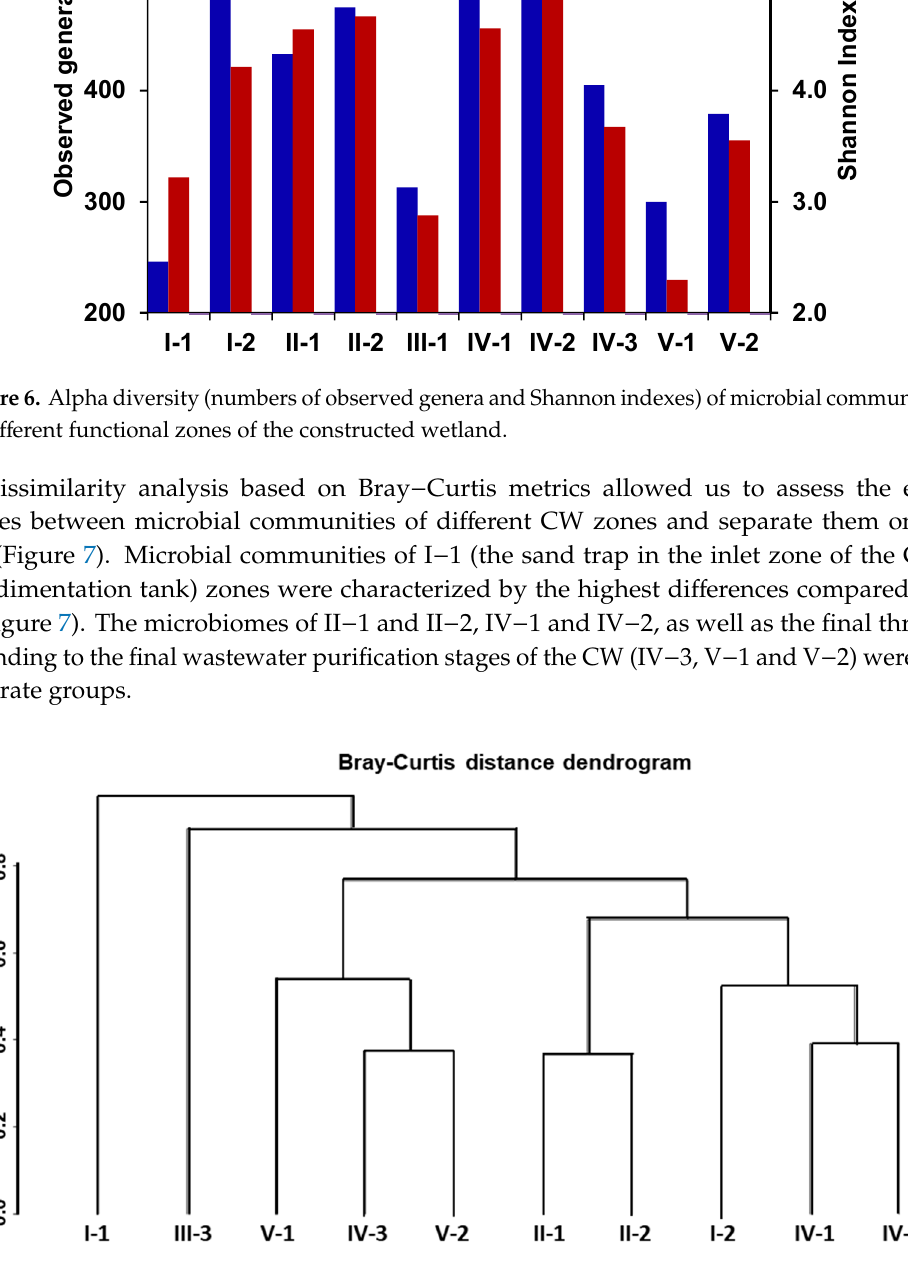
Figure 7. Microbiome clustering dendrogram of di ff erent functional zones of the constructed wetland based on Bray − Curtis (BC) distance